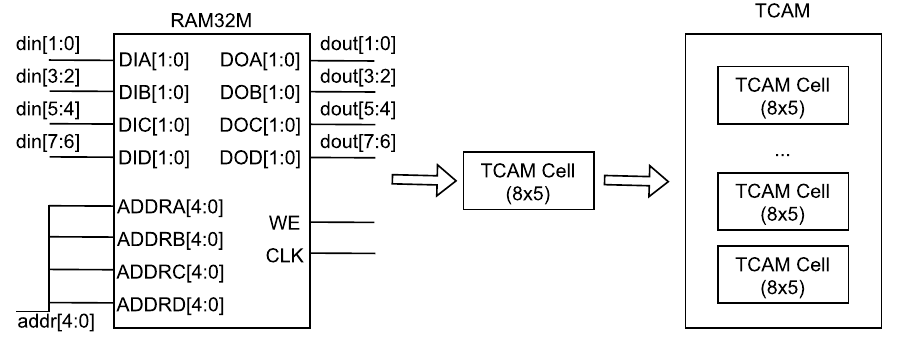
Figure 5. The design of the TCAM.